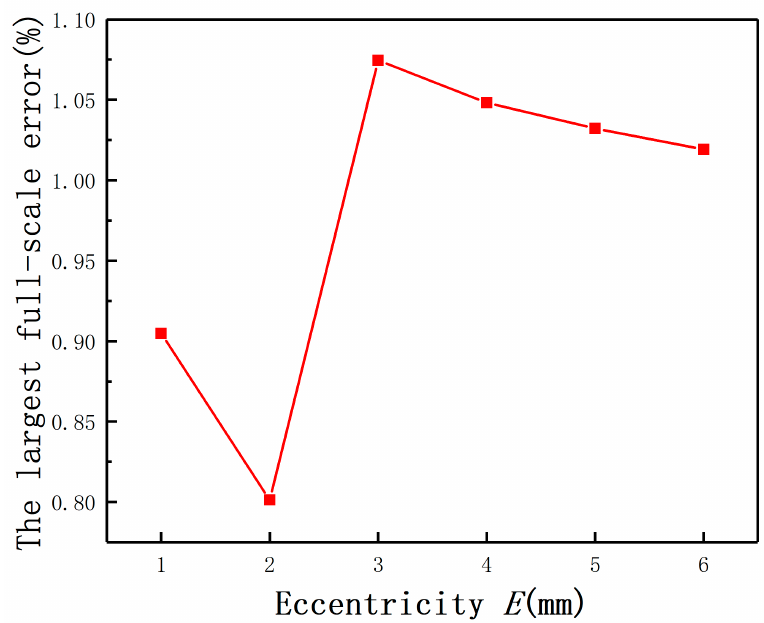
Sensors 2020 , 20 , x Figure 21. The largest full-scale errors after compensation. Figure 21. The largest full-scale errors after compensation.